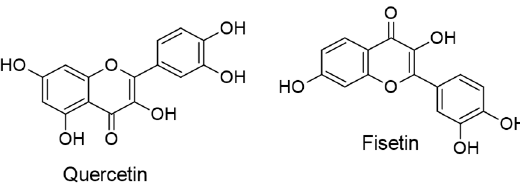
Figure 6. Chemical structures of flavonols with therapeutic actions against EBV-associated cancers.